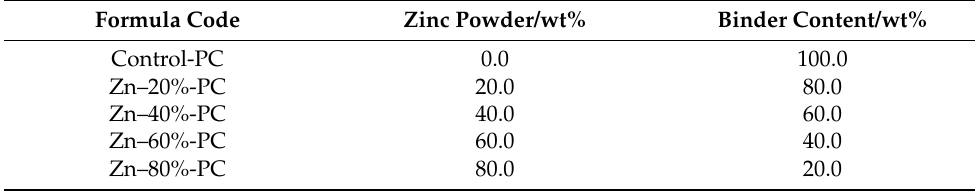
Table 1. Formulae of zinc-rich powder coatings in a polyester/TGIC binder.